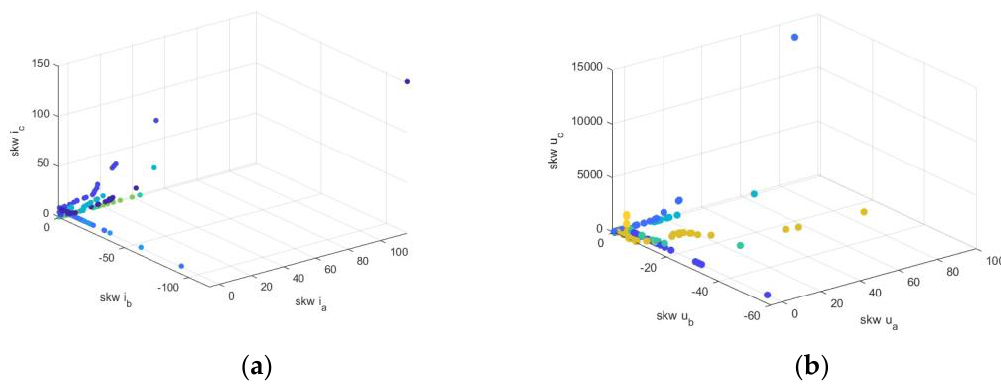
Figure 12. Dependence of skewness of the ( a ) currents 𝑖 𝑎 , 𝑖 𝑏 , 𝑖 𝑐 and ( b ) voltages 𝑢 𝑎 , 𝑢 𝑏 , 𝑢 𝑐 .